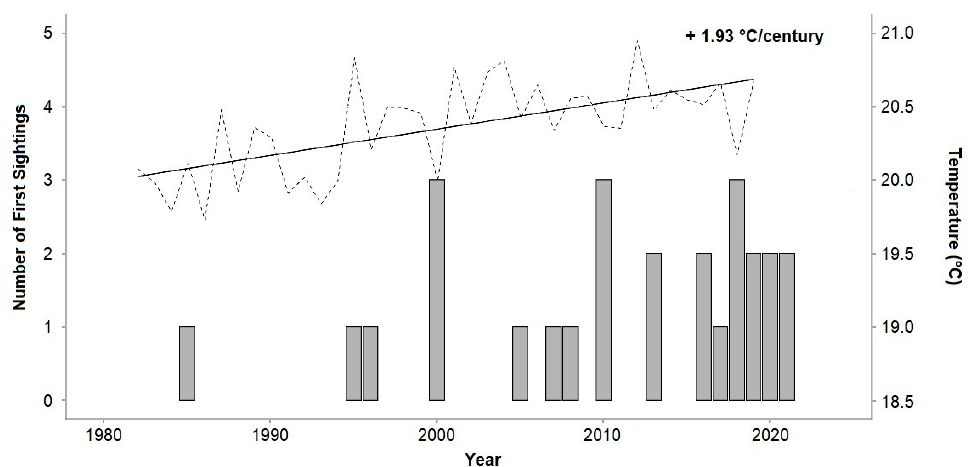
Figure 2. The number of first sightings of Chilomycterus reticulatus in Madeira per year, reported on the online survey. Sea surface temperatures in Madeira are displayed as yearly averages between 1982 and 2020 (dashed line). The extrapolated temperature change over a century (solid line) was calculated as a linear regression based on the seasonally adjusted dataset of daily means. Data: NOAA OI SST V2 High Resolution Dataset [63].